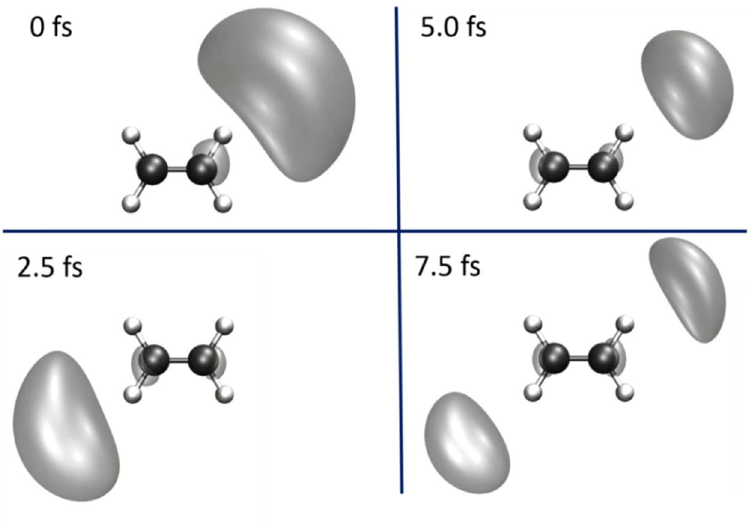
Figure 6. Snapshots of the time-dependent hole density in ethylene. The complete animation produced in the calculation is included in the supplemental information.